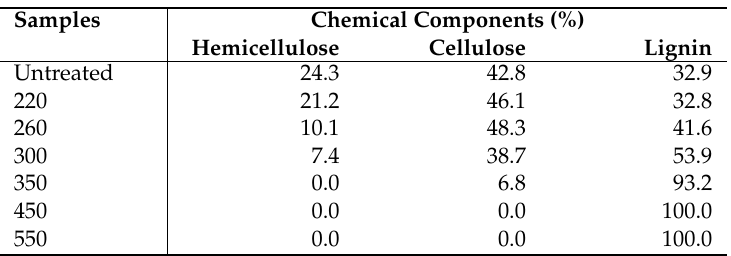
Table 1. Calculated cell wall chemical component of untreated and treated woods at each treatment temperature based on thermogravimetric analyzer (TGA)